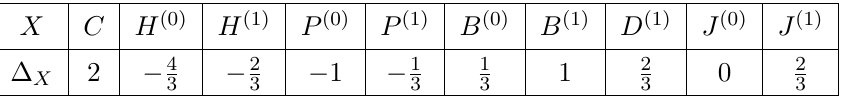
, t , x and x (0) (1) (0) (1)